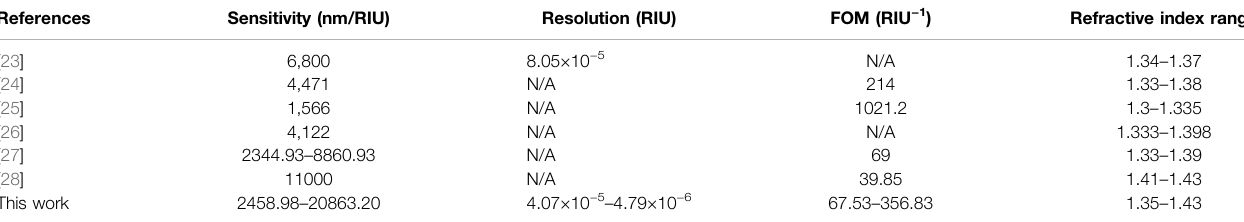
TABLE 1 | D-shaped SPR-based sensor performance comparison using the wavelength interrogation